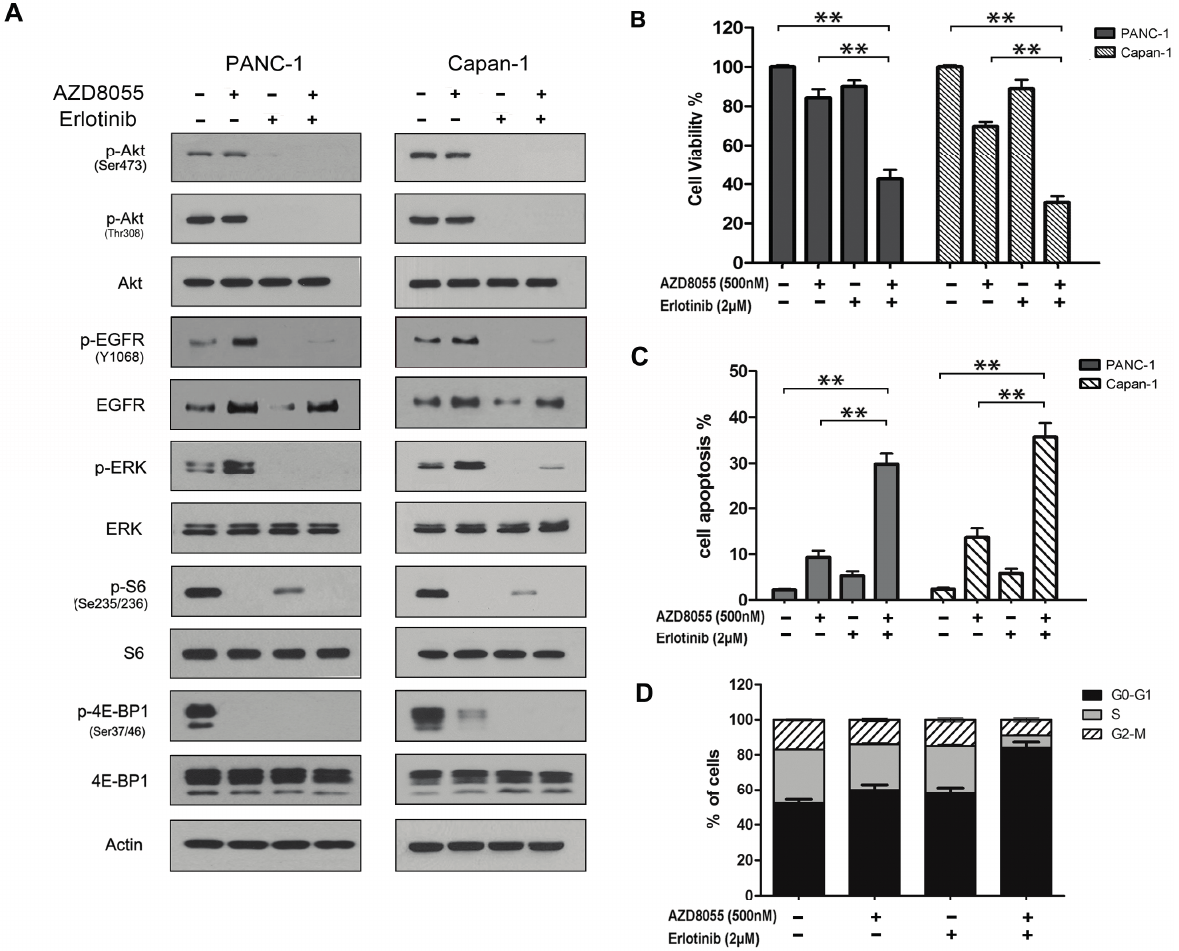
proteins AKT and ERK and partly inhibited the phosphorylation of S6 or 4E-BP1 [28]. In contrast, the combination of erlotinib and AZD8055 effectively inhibited both mTOR and EGFR, as well as their substrate activities (Figure 4A). Then, the MTT assay showed that erlotinib synergistically enhanced the cell growth inhibition of AZD8055 and that the combination of AZD8055 and erlotinib caused more than 60% cell growth inhibition compared with AZD8055 (less than 30%) or erlotinib (less than 20%) treatment alone (Figure 4B). These data indicated that erlotinib could effectively sensitize pancreatic cancer cells to AZD8055.